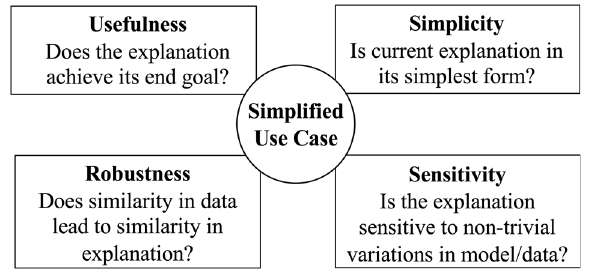
Fig. 18 Graphic summary of explanation evaluation core ideas. An explanation should fi rst be evaluated with a simple use case where the ground truth is clear and the explanation quality can be easily determined. A good explanation should be useful, robust, simple, and